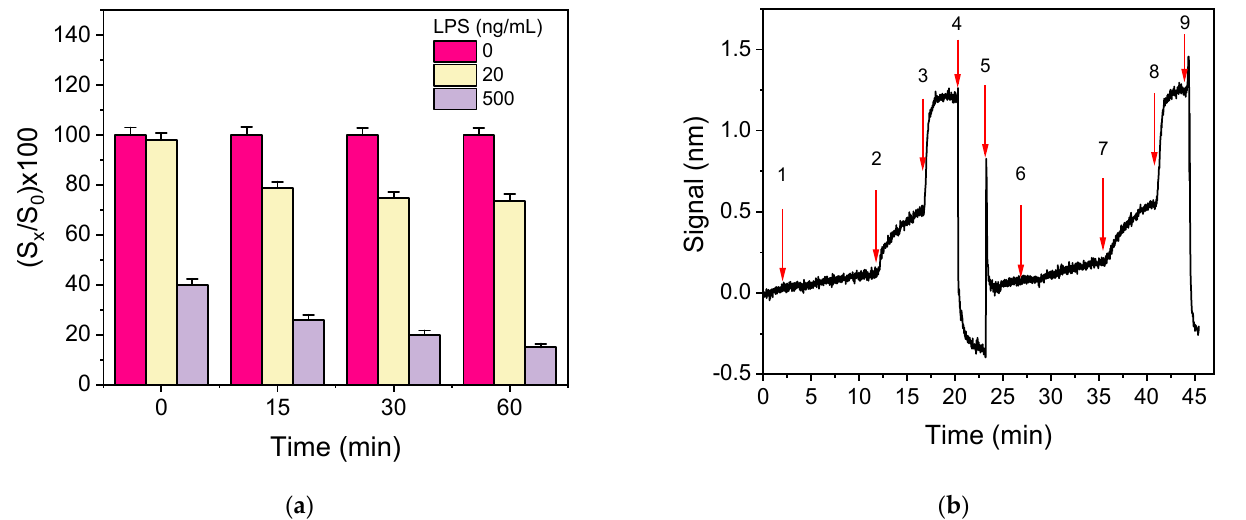
Figure 6. ( a ) Percent signal values obtained for the zero calibrator (magenta columns) or a calibrator containing 20 (yellow columns) or 500 ng/mL of LPS (grey columns) without or with 15, 30, and 60 min pre-incubation of the calibrators with the anti- Salmonella antibody solution (1.5 μ g/mL). Each column represents the mean value of five measurements ± SD. ( b ) Real-time sensor response obtained upon running zero calibrator prepared in assay buffer (arrows 1–4), regeneration (arrows 4–6), and zero calibrator in bottled water (arrows 6–9).